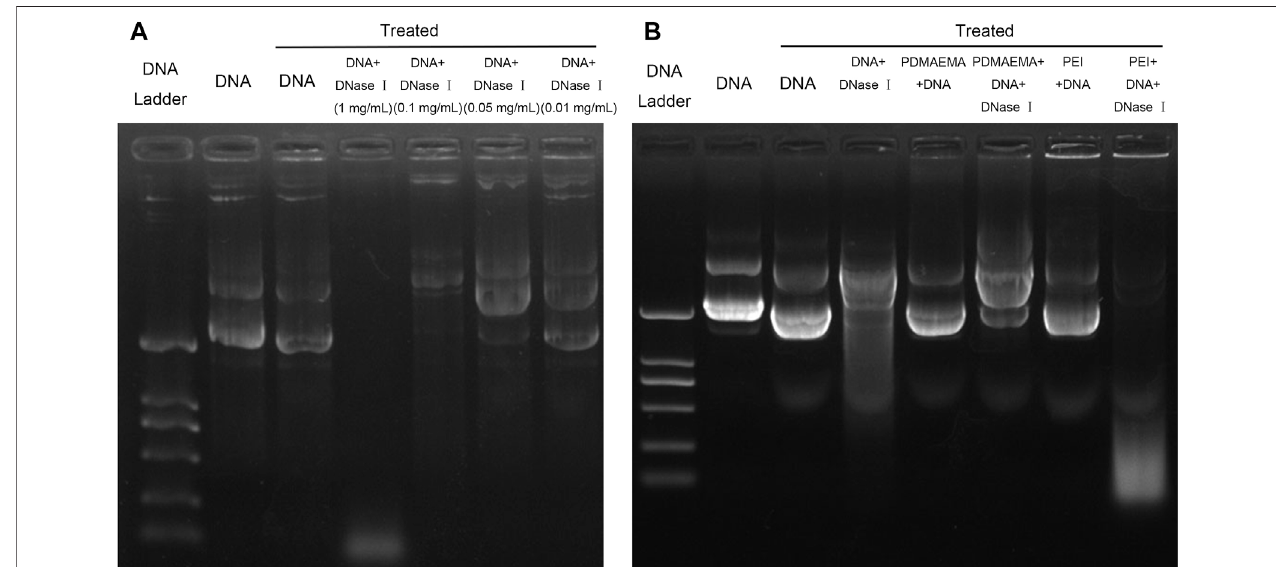
FIGURE 2 | Plasmid DNA protection assay. (A) Same amount (1 μ g) of pDNA treated by DNase I was run on a 1% agarose gel to determine the optimal DNase I concentration for DNA degradation. (B) Agarose gel electrophoresis of DNA, PDMAEMA + DNA (N/P ratio of 4.38:1), and PEI + DNA (N/P ratio of 2.6) incubated with DNase I to evaluate DNA protection against nuclease